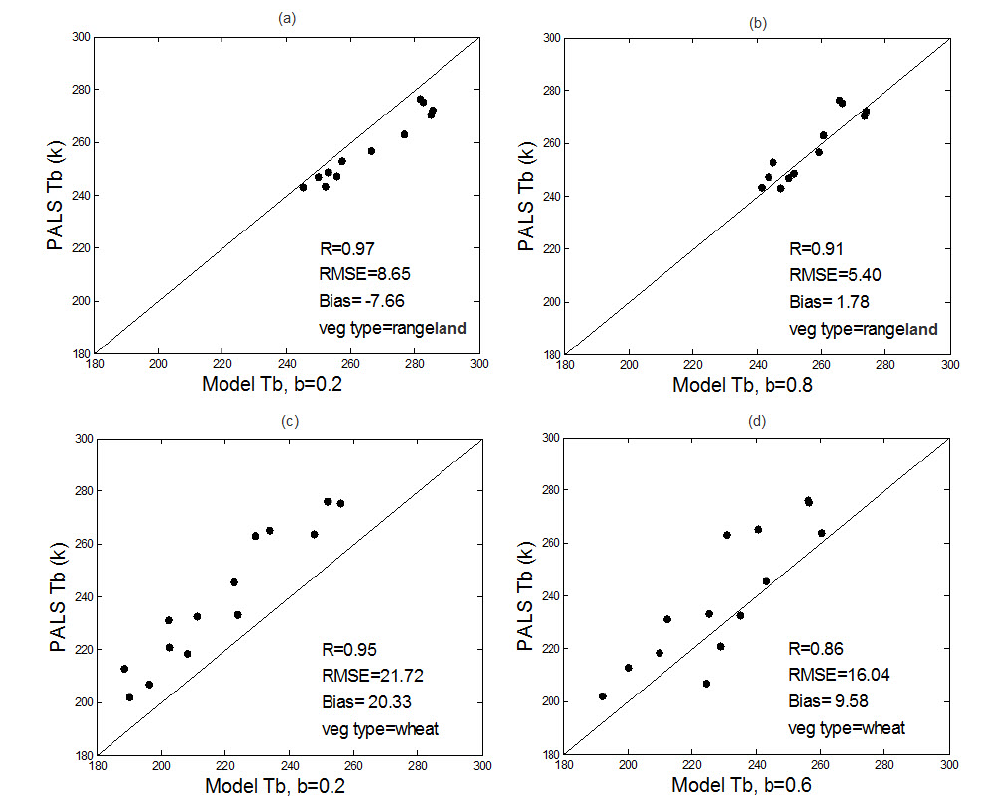
Figure 6. Correlation between PALS measured and calculated by Model: LW 4,